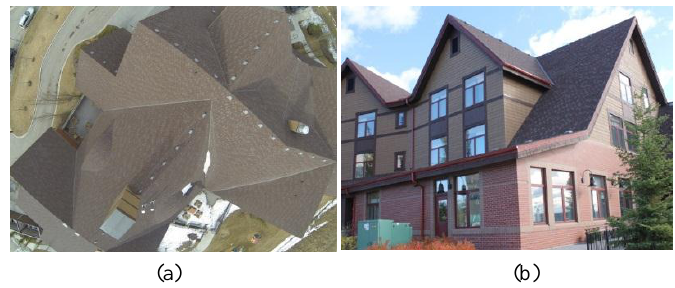
Figure 5. (a) A sample UAV image and (b) a sample image captured by the hand-held Canon Rebel T3 digital camera